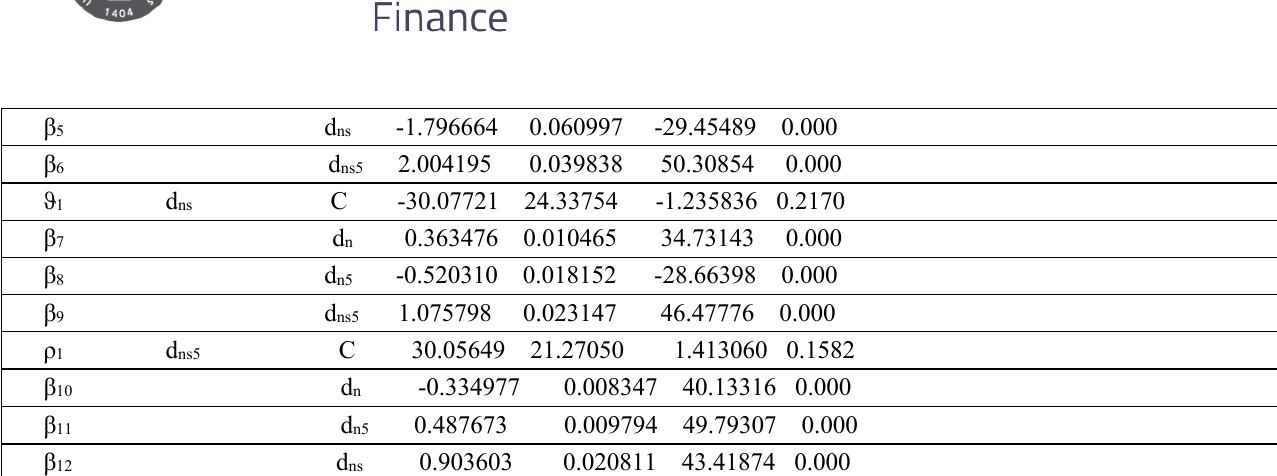
Table 7. Estimation Method: Generalised Methods of